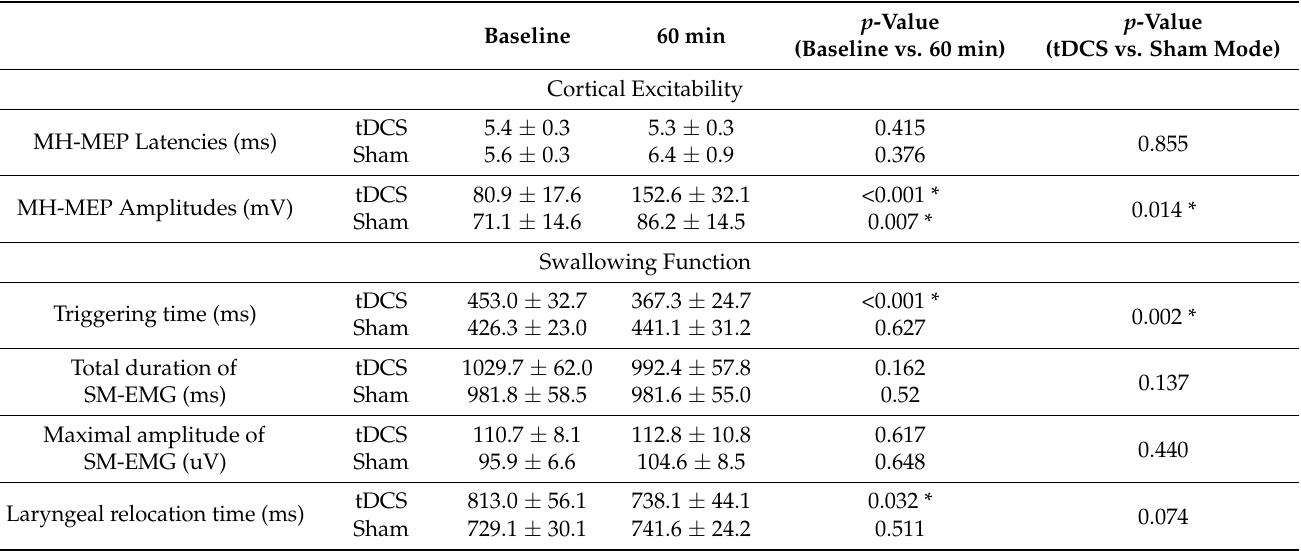
Table 2. Comparison of tDCS and sham mode tDCS between post-inhibitory rTMS (baseline) and 60 min after intervention.